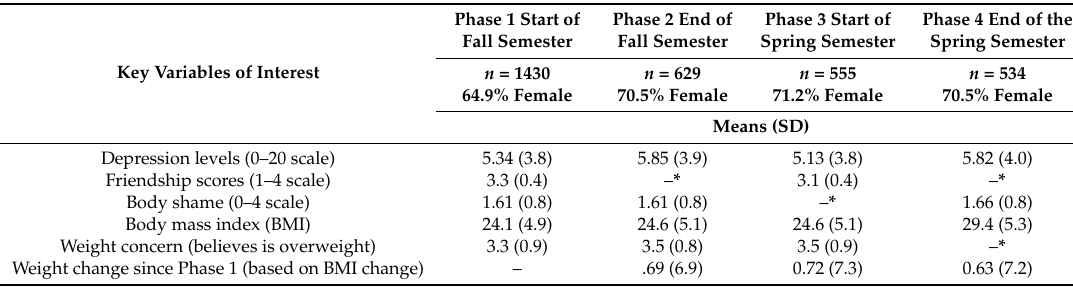
Table 1. Mean descriptives by phase.